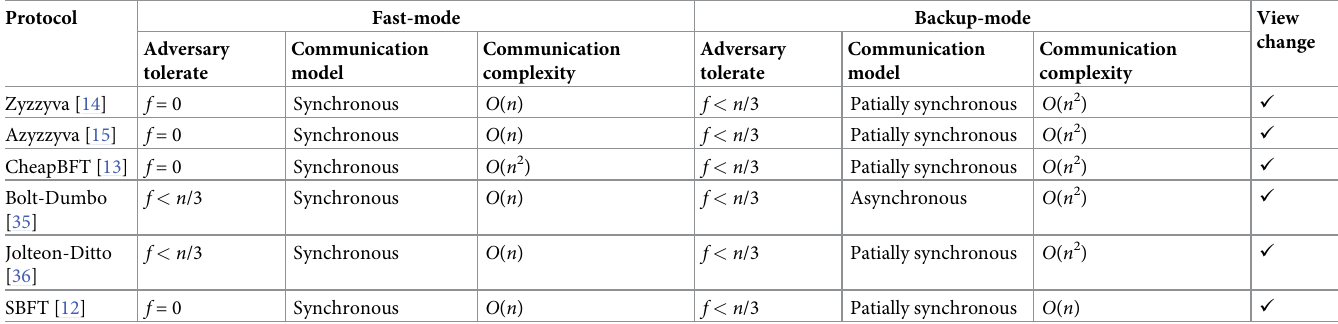
Table 2. Comparison of dual-mode consensus